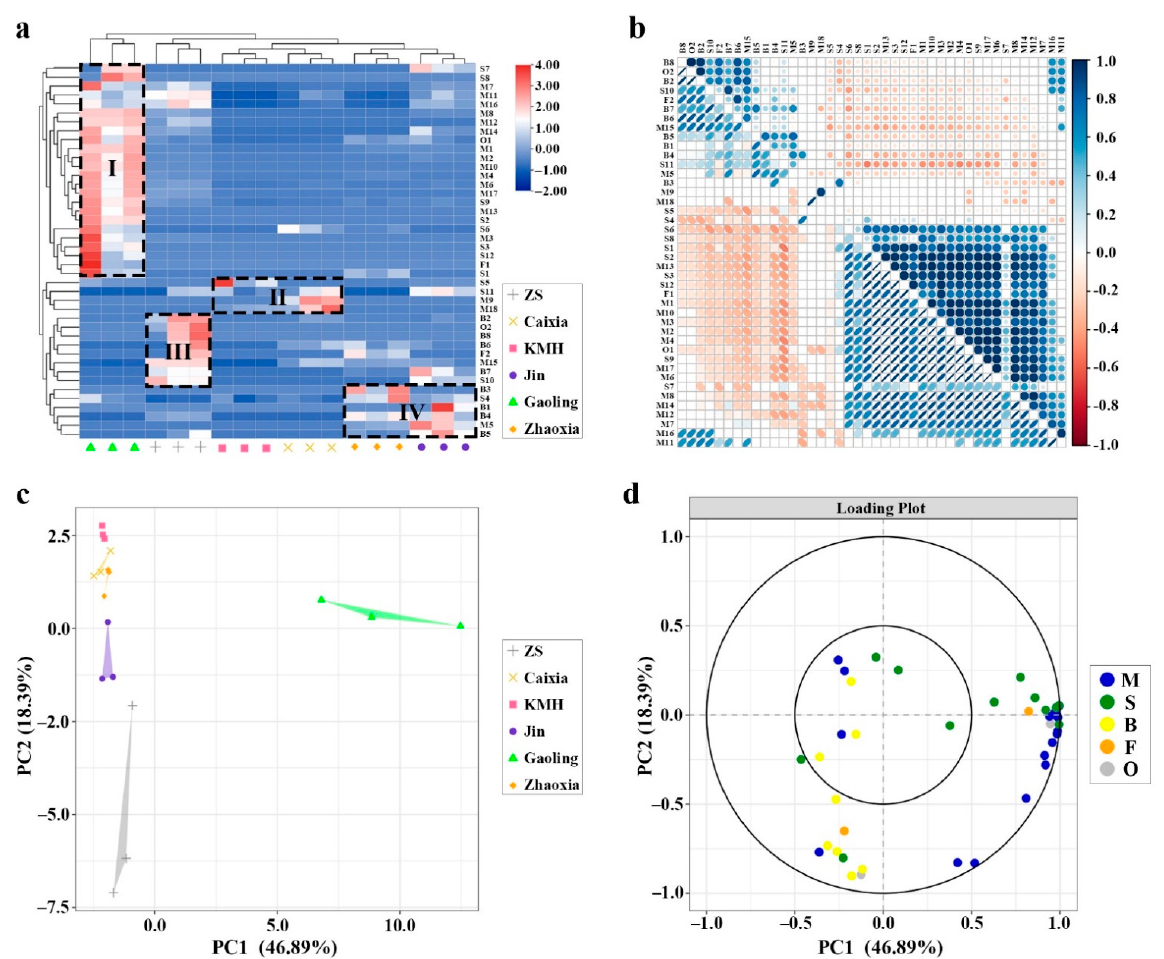
Figure 2. Multivariate analysis of floral volatile profiles of six Hedychium accessions assessed by HS–SPME–GC–MS. ( a ) Heat map of volatile compounds in six Hedychium accessions. ( b ) Correlation matrix of 42 VOCs (significant ( p < 0.05) combinations are displayed). ( c ) The distribution of VOCs of six Hedychium accessions over the PCA score plot defined by the first two principal components. ( d ) The projection of the VOCs identified by HS–SPME–GC–MS analysis. Each compound is shown in a different color (monoterpenoids (M), sesquiterpenoids (S), benzenoids/phenylpropanoids (B), fatty acid derivatives (F), others (O)).